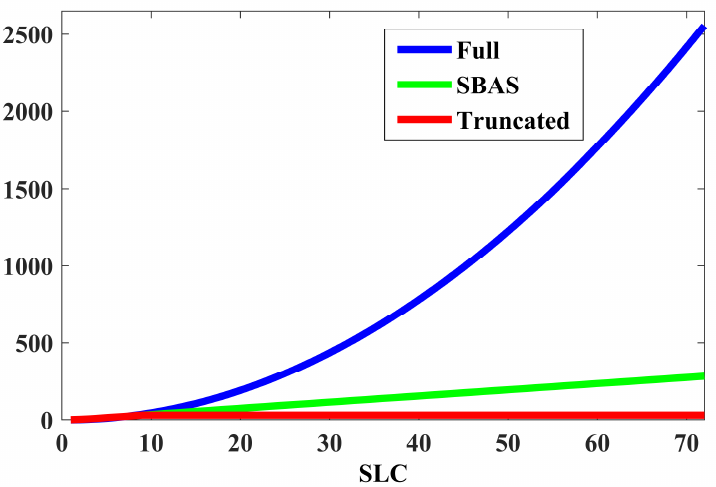
Figure 6. Chart showing the number of interferograms using full, SB, and truncated SB strategies in temporal phase optimization method.